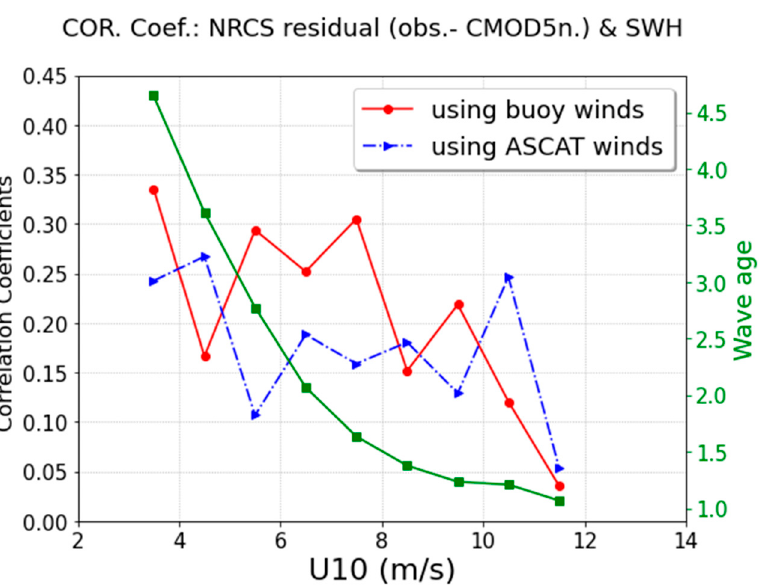
Figure 4. Correlation coefficients between normalized radar cross section (NRCS) residual (ASCAT measured minus geophysical model function (GMF) of CMOD5n predicted) and SWH for various wind speed bins. Red and blue symbols denote the inputs to CMOD5n from winds derived from ASCAT or measured by the buoy. Green squares present the corresponding wave age for each wind